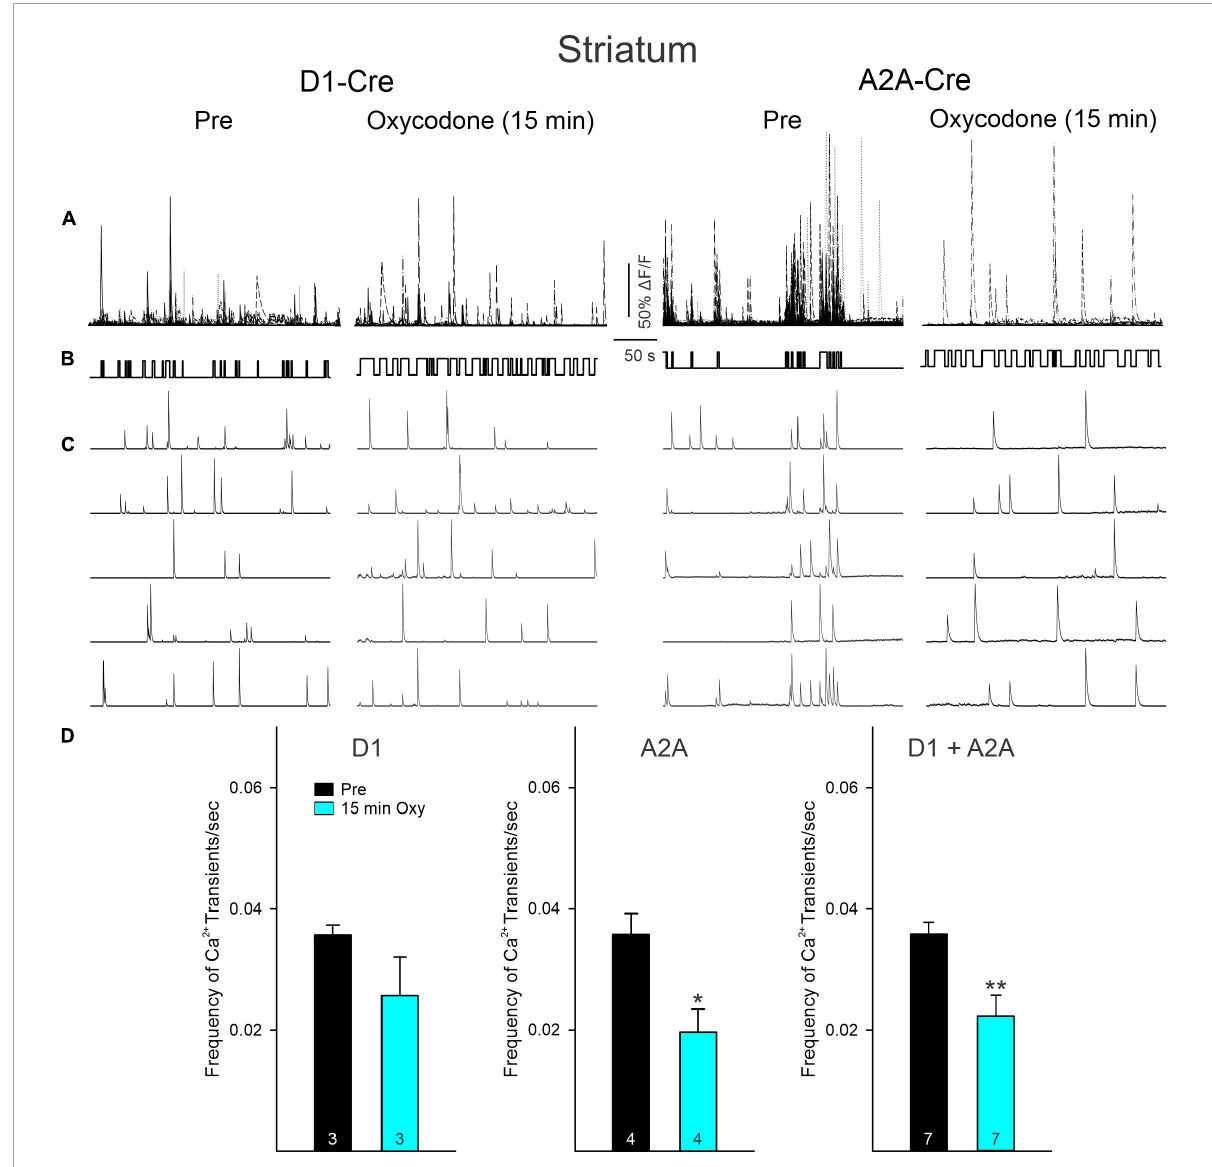
FIGURE3 (A) Traces represent multi-neuronal Ca 2 + transients recorded in D1- and A2A-Cre mice before (Pre) and 15 min after oxycodone. Each trace represents the activity of 1 medium-sized spiny neuron (MSN). Notice that the number of active cells is reduced after oxycodone. (B) Upward deflections indicate the mouse was moving. In control conditions the behavior appeared more random, whereas after oxycodone it became more stereotyped. (C) Some representative Ca 2 + transient traces of single MSNs. Notice the tight correlation between Ca 2 + transients